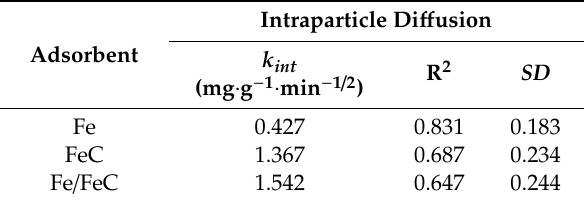
Table 7. Intraparticle di ff usion kinetic parameter at 25 ◦ C for Acid Red 66 adsorption on the